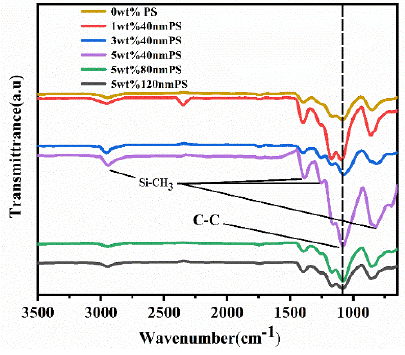
Figure 6. FT-IR spectra of blend films.